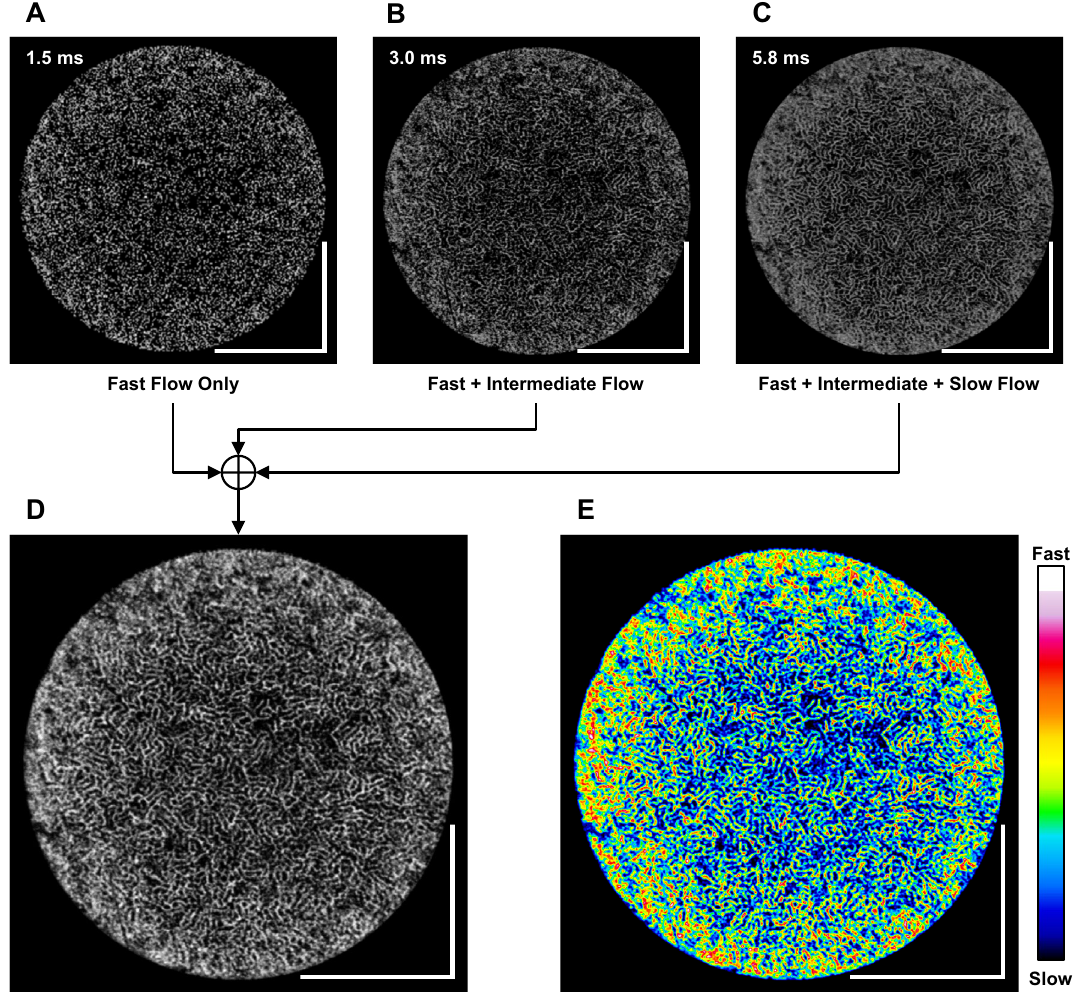
Figure 2. Semi-quantitative OCTA image processing. ( A – C ) Three raster scans with different inter-B-scan times were sequentially acquired over the same field of view. ( D ) En face projected three OCTA images were summated to generate semi-quantitative OCTA image. ( E ) False-color mapping helps visual perception of the fast and slow blood flow speeds. Scale bars 1